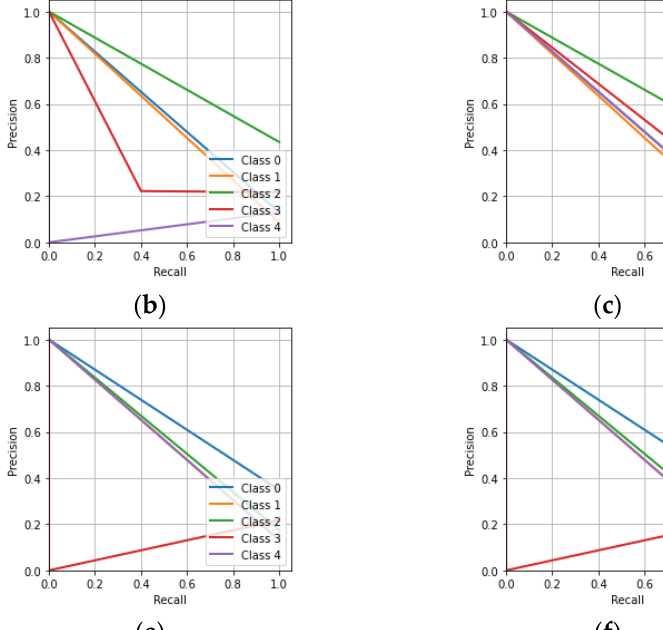
Figure 10. Precision-recall characteristics for the hologram dataset: ( a ) CNN; ( b ) KNN; ( c ) MLP; ( d ) DT; ( e ) RF; ( f ) ET.